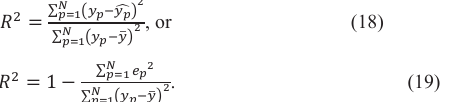
(cid:2870) (cid:3627)(cid:3052) (cid:3291) (cid:2879)(cid:3052) (cid:3291) (cid:3550)(cid:3627) (cid:3052) (cid:3291)